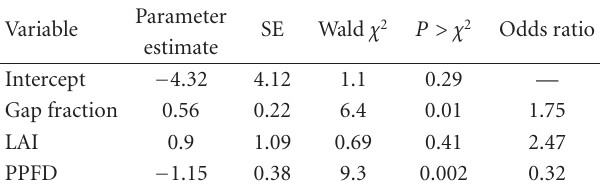
Table 5: Parameter summary of the best supported model compar- ing female Myotis septentrionalis day roosts used during lactation and non-lactation periods on the Fort Knox military reservation in Hardin, Bullitt, and Meade counties, Kentucky, USA,